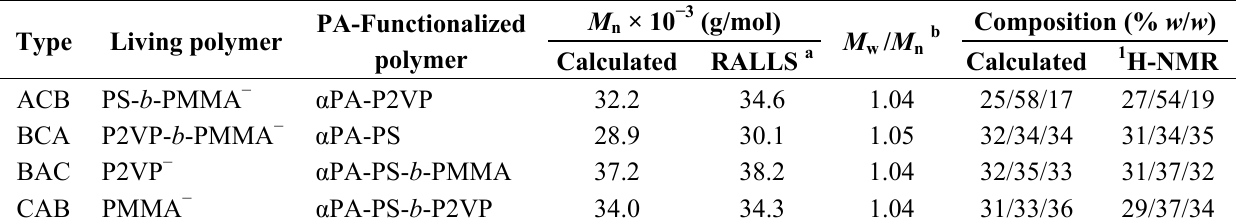
Table 5. Molecular characteristics of ACB (BCA) and BAC (CAB) triblock